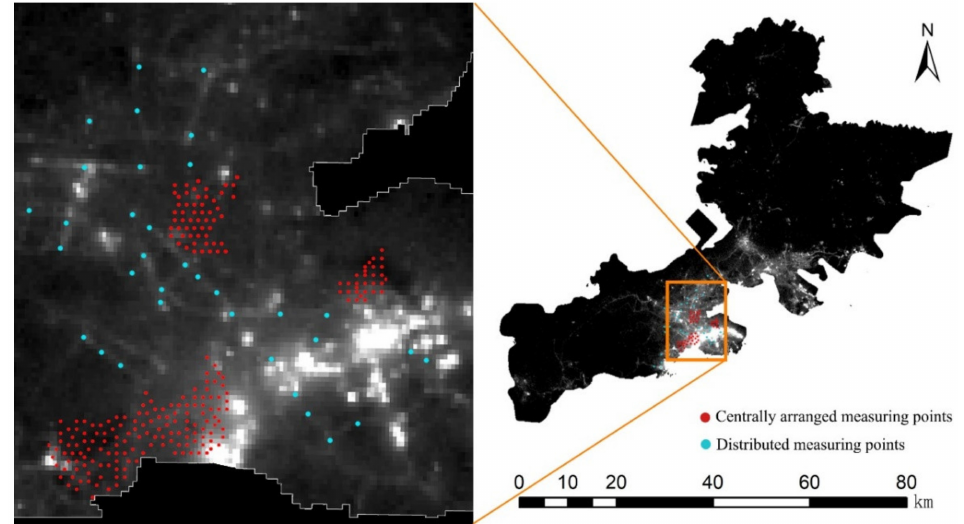
Figure 3. Distribution map of measurement